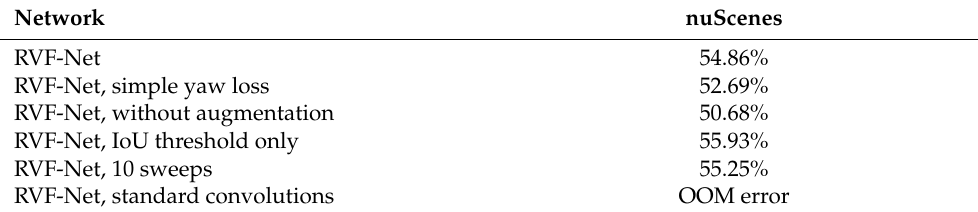
Table 3. AP scores for different training configurations on the validation data